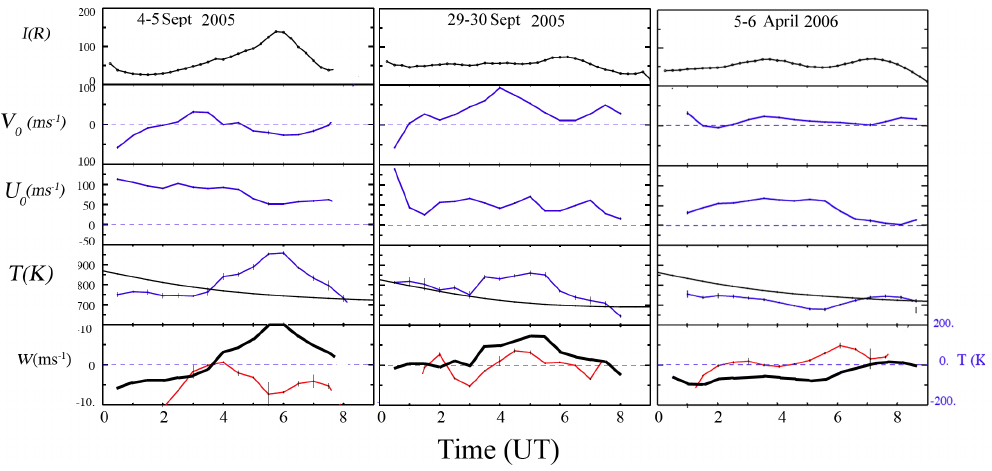
Fig. 8. Results for 3 nights with dates near equinox: September 2005 and early April 2006, respectively. The top three rows show the temporal variations of the averaged 630-nm intensity and mean speeds for the horizontal meridional ( v 0 ) and zonal ( u 0 ) wind components, respectively. The fourth row shows the time sequence of cycle-averaged temperatures (blue data points and line) compared with the NRL- MSIS00 model (black line). The bottom row presents temporal variations of the vertical wind (red line) and the temperature difference (black line, FPI data minus NRL-MSIS00